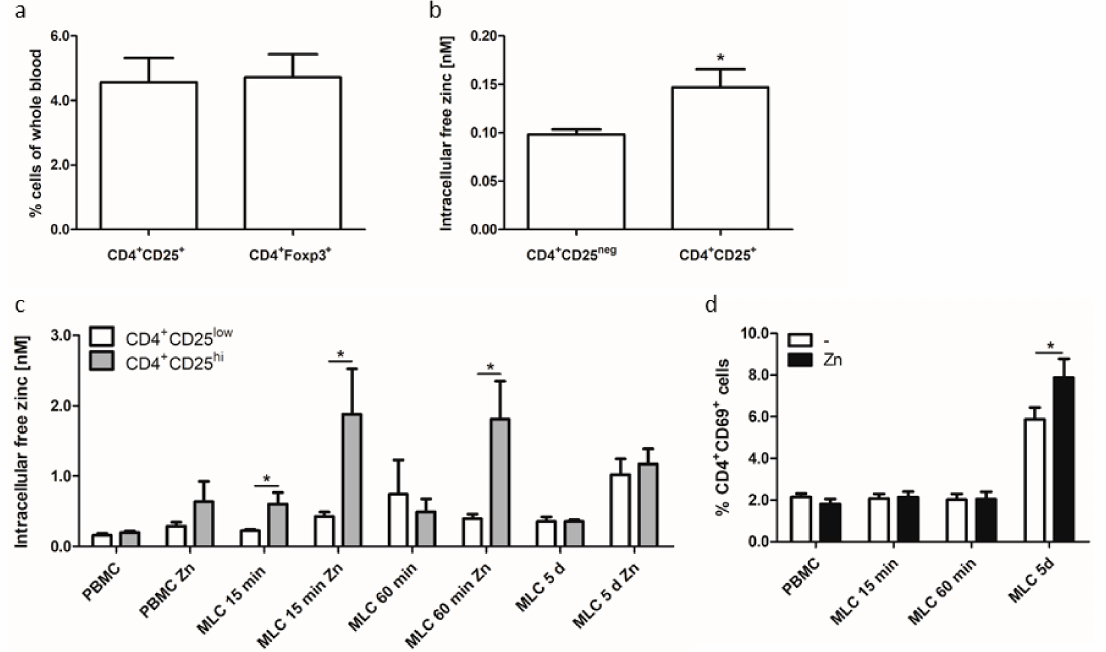
Figure 1. Intracellular free zinc level substantially increased in allogeneic activated regulatory T cells (Tregs). ( a,b ) Whole blood was taken from healthy volunteers and parameters were measured directly without delay or separation. ( a ) Non-activated whole blood samples were analyzed regarding cellular percentage of CD4 + CD25 + and CD4 + FOXP3 + expressing Tregs. ( b ) Intracellular free zinc level is displayed for CD4 + CD25 + Tregs and CD4 + CD25 neg T cells. ( c,d ) 2 × 10 6 peripheral blood mononuclear cells (PBMCs)/mL were pre-incubated with 50 µ M zinc (15 min) or remained untreated. Subsequently, mixed lymphocyte cultures (MLCs) were generated for 15 min, 60 min, and five days. ( c ) Measurement of the free intracellular zinc level was performed by Fluozin3-AM in gated Th cell populations: CD4 + CD25 low T cells (white bars) and CD4 + CD25 hi T cells (grey bars). ( d ) Activated (CD4 + CD69 + ) Th cells in PBMCs and MLCs are displayed. ( + : positive, expression, low : low expression, hi : high expression, neg : negative, no expression) All data are shown as means + SEM (standard error of mean) of n = 4–6 independent experiments (* p < 0.05, Student’s t